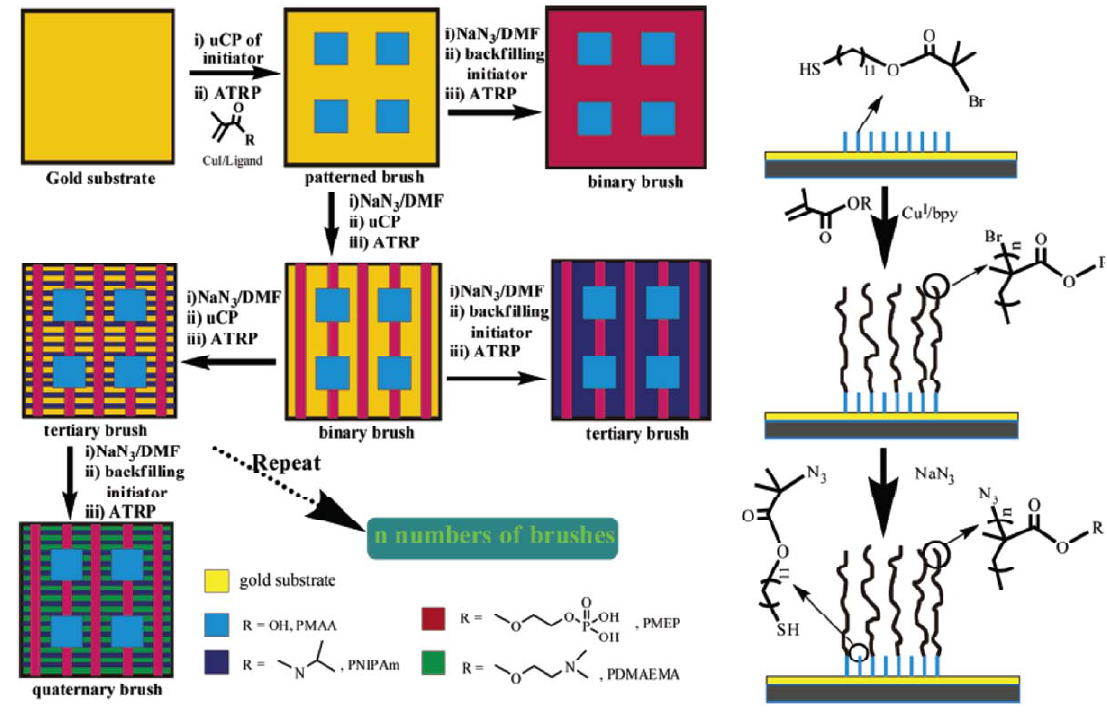
Figure 13. Outline procedure for grafting multiple patterned polymer brushes and ATRP passivation. Reprinted from Reference [156] with